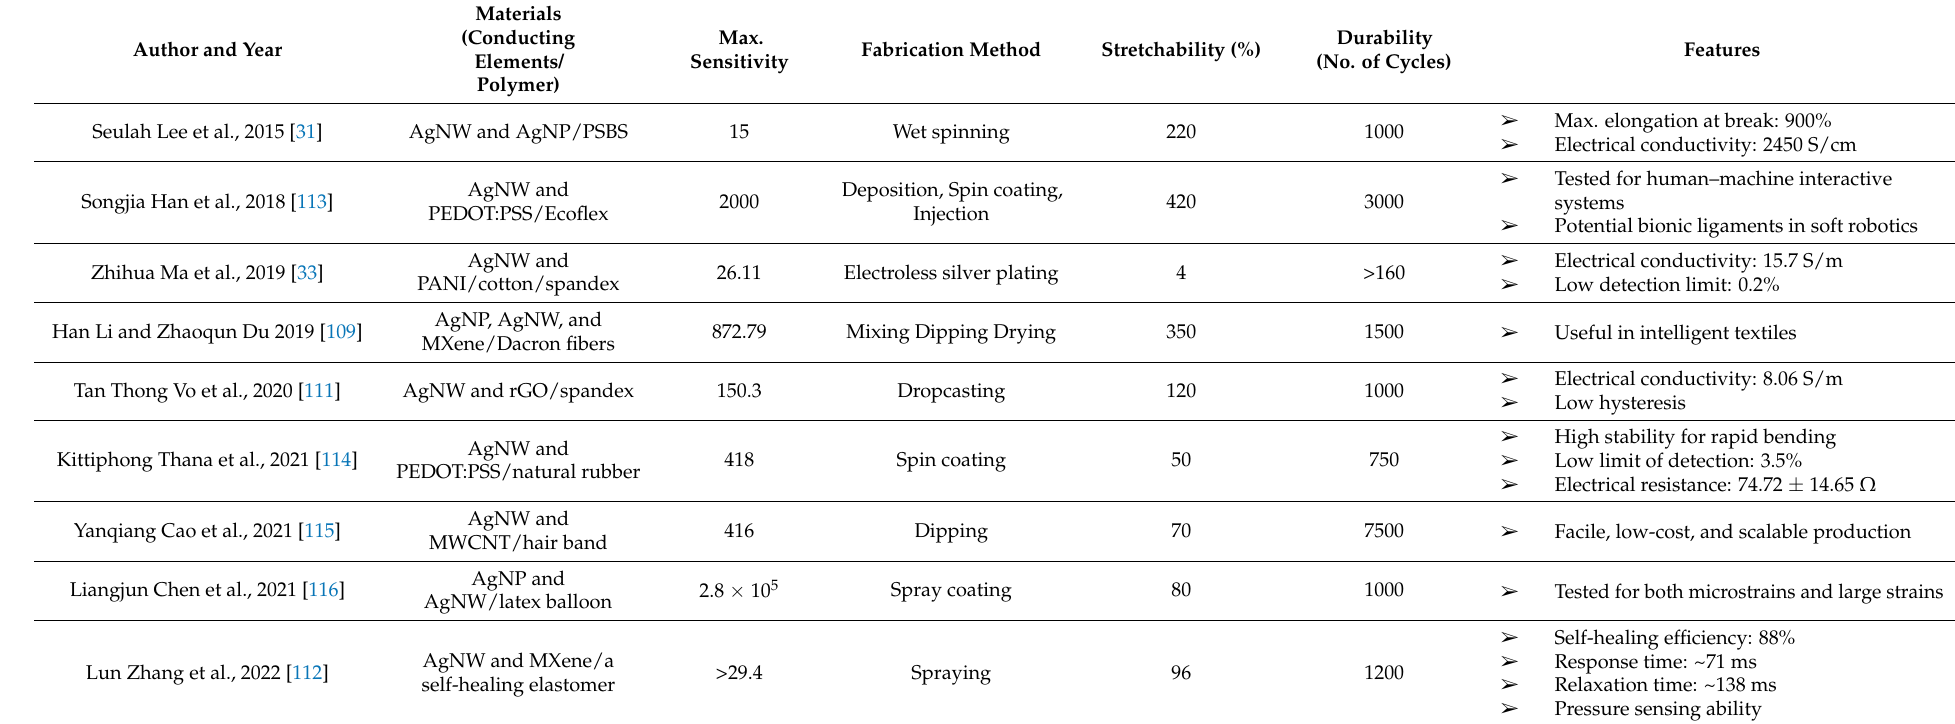
Table 6. Overview of stretchable sensors using AgNWs as additional filler in other